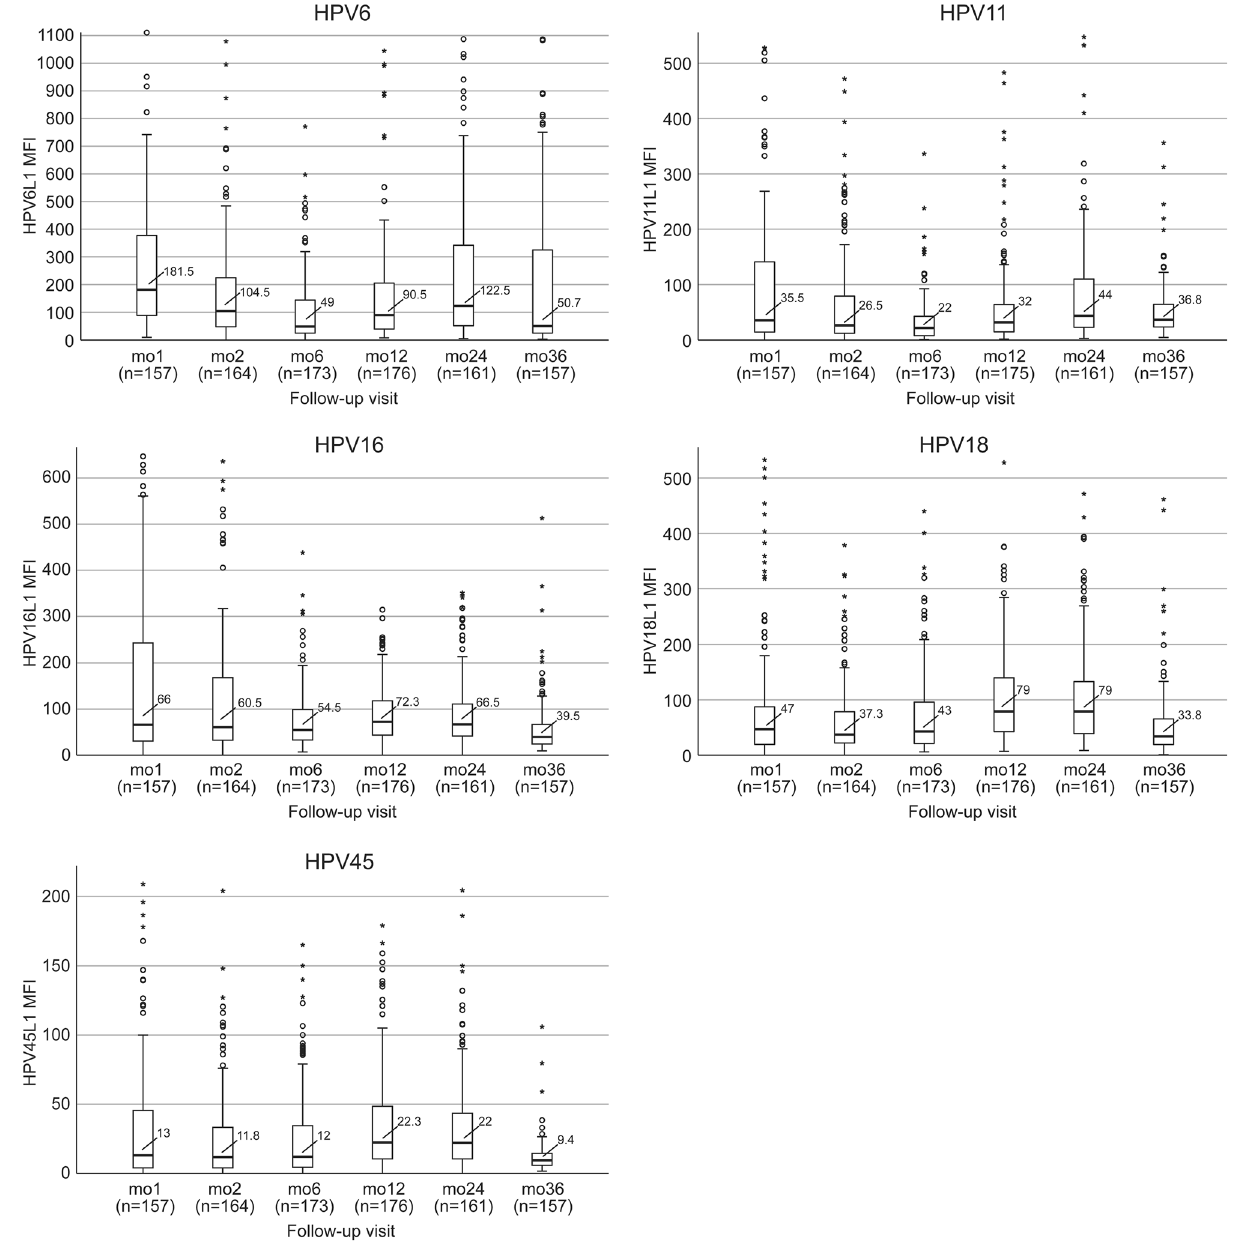
Figure 2. Antibody-levels to HPV6, HPV 11, HPV16, HPV18 and HPV45 in offspring born to seropositive mothers defined by MFI 200 or more for any HPV type. In total 179 of the 327 pregnant mothers were seropositive to HPV6, HPV 11, HPV16, HPV18 or HPV45 L1 protein (cut-off, any HPV type > 200 MFI). The mean HPV antibody levels and the range in their offspring are given as columns stratified by HPV serotypes and follow-up visits. The number of tested offspring (= n) of the seropositive mothers are given in parenthesis under the horizontal axis at the different follow-up visits (mo = month). Unfortunately, blood samples were not available from all infants at all different time points, and this is the reason why the numbers are not